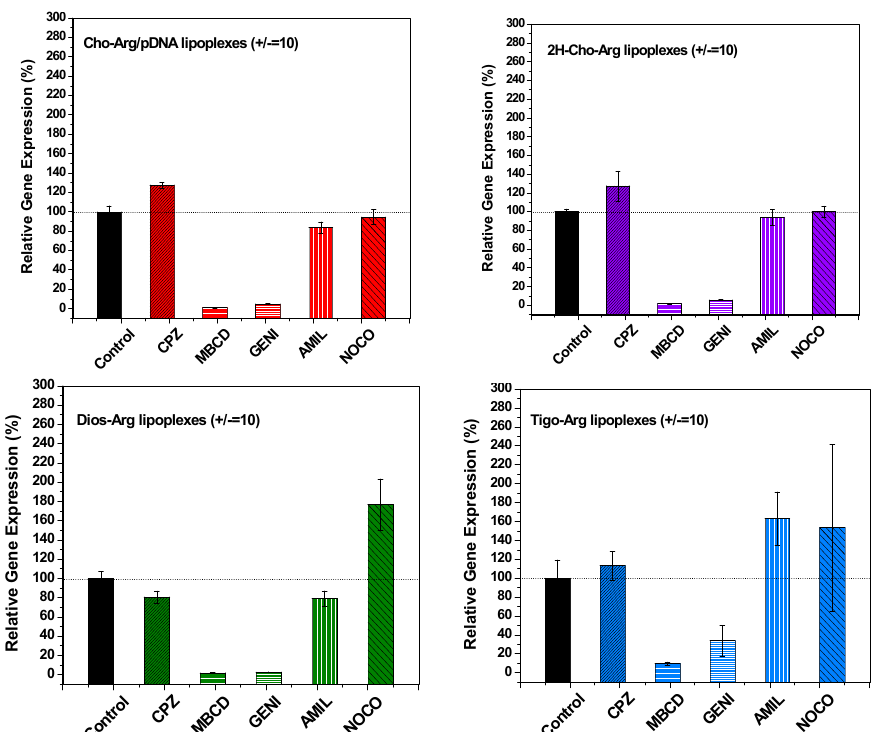
Figure 7. Endocytosis pathway analysis of the steroid-based cationic lipids/pDNA lipoplexes ( ± = 10) in H1299 cells by measuring the relative luciferase gene expression in the presence of different endocytosis-specific inhibitors: Chloropromazine (CPZ, clathrin-mediated endocytosis inhibitor); Methyl- β -cyclodextrin (MBCD, lipid-raft mediated endocytosis inhibitor); Genistein (GENI, caveolae mediated endocytosis inhibitor); Amiloride (AMIL, macropinocytosis mediated endocytosis inhibitor); and Nocodazole (NOCO, microtubule and actin inhibitor). To get more insight into the cellular fate, the intracellular localization of the Cy3-pDNA-loaded lipoplexes in H1299 cells were observed by fluorescence microscope, with Lipo2000/Cy3-pDNA as the control. The cell nuclei and lysosome were separately labeled with fluorescent dyes DAPI (blue) and Lysotracker (green). As shown in Figure 8, after 4 h transfection with Cho-Arg/Cy3-pDNA and 2H-Cho-Arg/pDNA lipoplexes, strong red fluorescent spots were found within or around the DAPI-stained nucleus and part of them colocalized with the lysotracker-stained lysosome,; Lipo2000/Cy3-pDNA lipoplexes showed similar localization effects. Meanwhile, with the transfection of Dios-Arg/Cy3-pDNA and Tigo-Arg/Cy3-pDNA lipoplexes, comparatively weaker red fluorescent spots were observed dispersed around or within the cell nuclei and lysosome, indicating their low cellular uptake capability, which may result in their low gene transfection efficiency. In prior works, we disclosed the lipoplexes of some cholesterol-disulfide cationic lipids (CHOSS) possess perinucleic localization effect [24], which may be due to the cholesterol-induced perinucleic localization. Moreover, we revealed that some ( l -)-arginine-rich peptide mimics could enable the nuclei-oriented pDNA localization [38]. Likewise, Ma et al. showed that the “proton sponge” feature of ( l -)-arginine could lead to lysosome localization effect [63]. Thus, in this case, the perinucleic, nucleic and lysosome localization effects of the steroid-based cationic lipids/Cy3-pDNA lipoplexes may be inferred as the synergistic contributions of the steroid hydrophobes/skeletons and